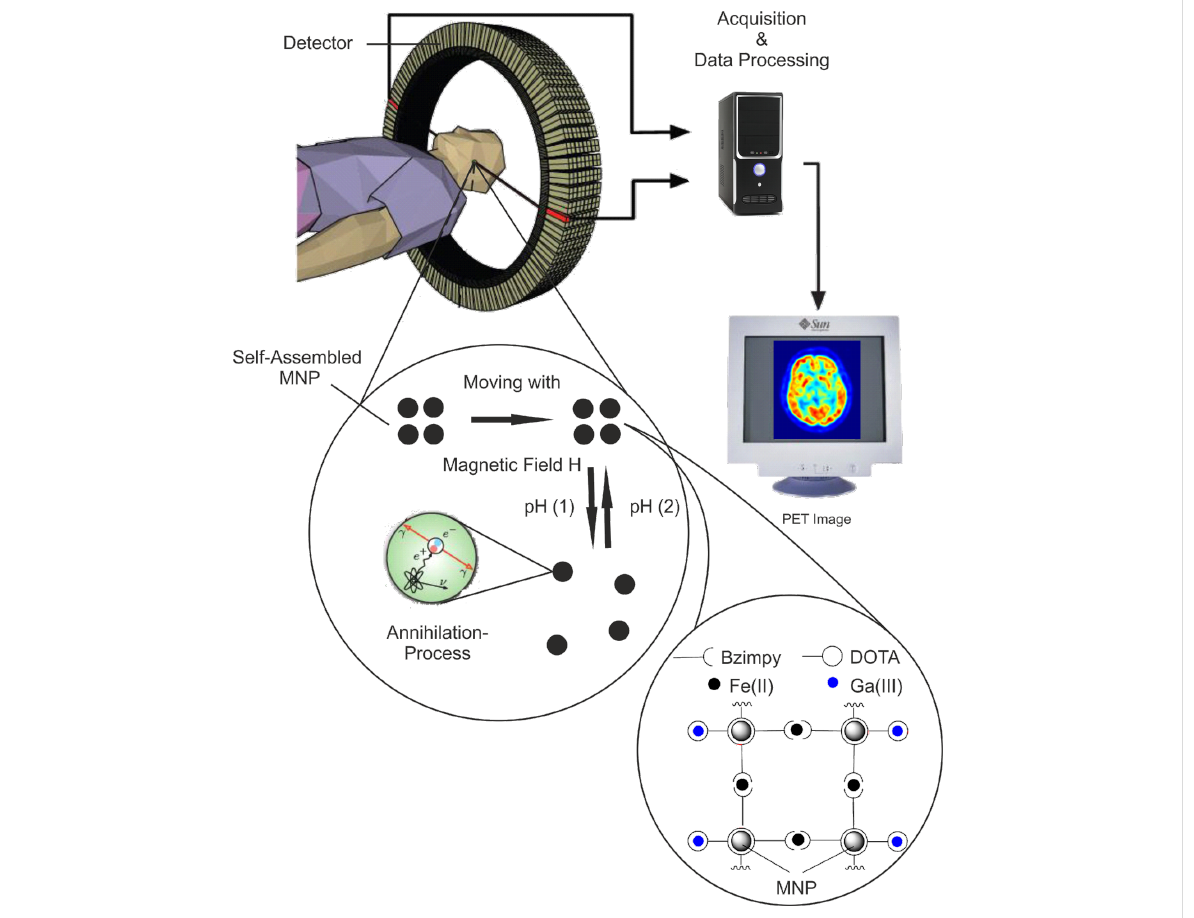
Figure 1: Model of a nanohybrid-PET-system. MNP can assemble and disassemble at different pH. The disassembled NP spread in the tumor cell and can be detected by PET